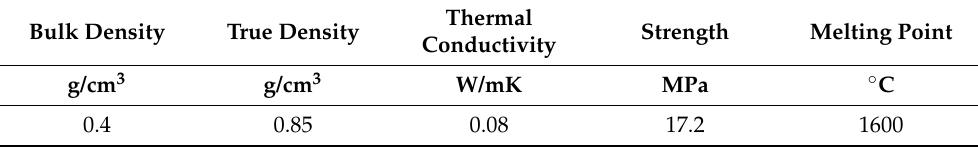
Table 2. Physical properties of FAC.